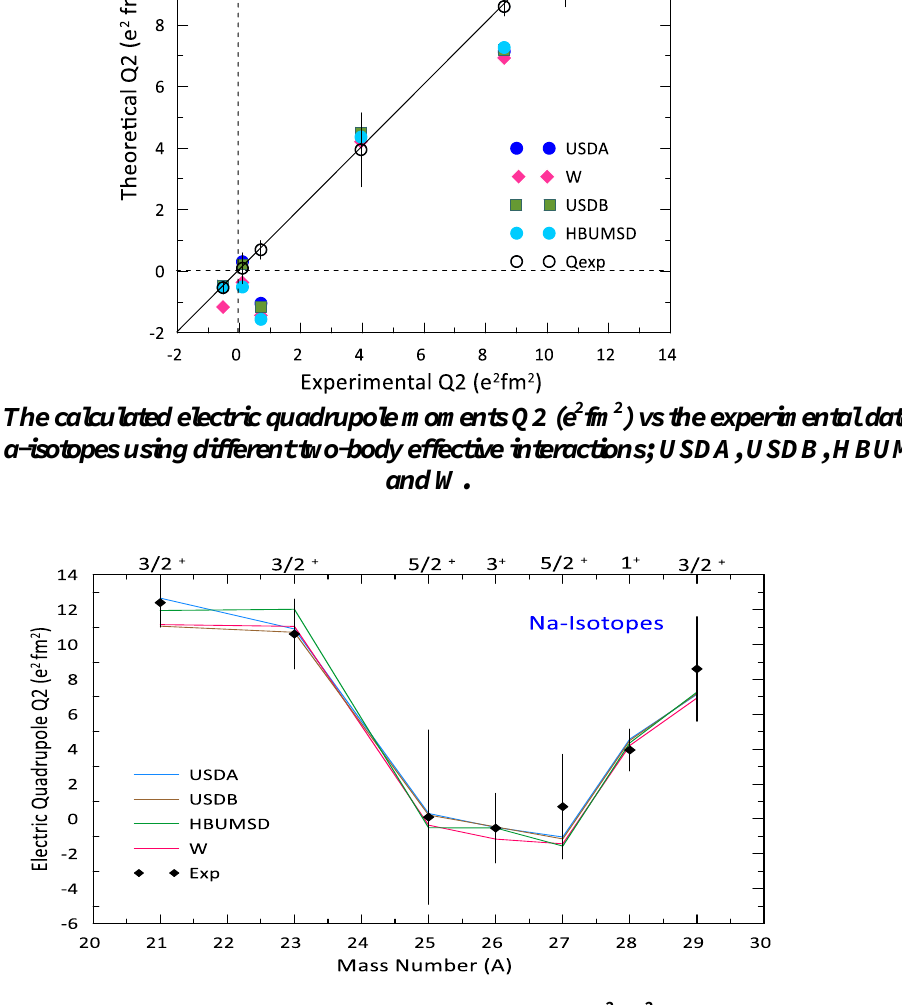
Figure 6: The calculated electric quadrupole moments Q2 (e 2 fm 2 ) vs mass number (A) for Na-isotopes using different two-body effective interactions compared to the experimental data of Refs. [16, 17]. Table 4: The theoretical calculated electric quadrupole moments in e 2 fm 2 for Na-isotopes using three different single-particle potentials; HO, WS, and SLy4 in comparison with experimental data taken from Refs. [16, 17]. Mass